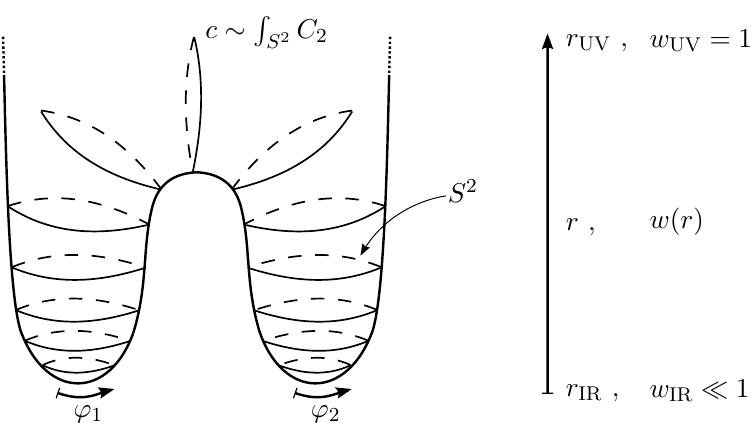
Figure 1 . An illustration of the setup of the double throat including the phases ’ i and the axion c . The phases ’ i describe physical rotations of each throat. We have not drawn the S 3 over every point of the double